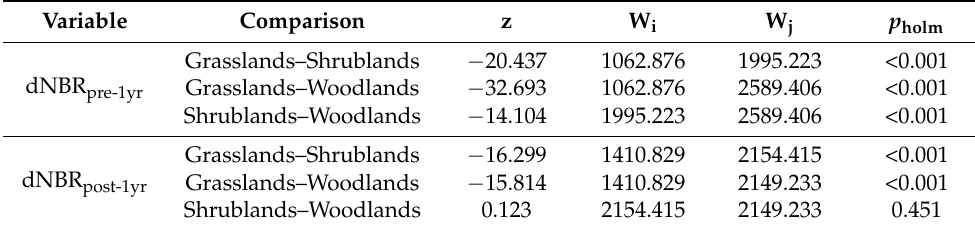
Figure 6. Boxplots of ( a ) dNBR pre-1yr and ( b ) dNBR post-1yr values in burned and unburned grasslands (GL), shrublands (SL,) and woodlands (WL). The boxes show the interquartile range, horizontal bars show median values, and vertical bars show the top and bottom 25% quartiles. Table 4. Dunn’s post hoc comparison for dNBR pre-1yr and dNBR post-1yr in the burned area.